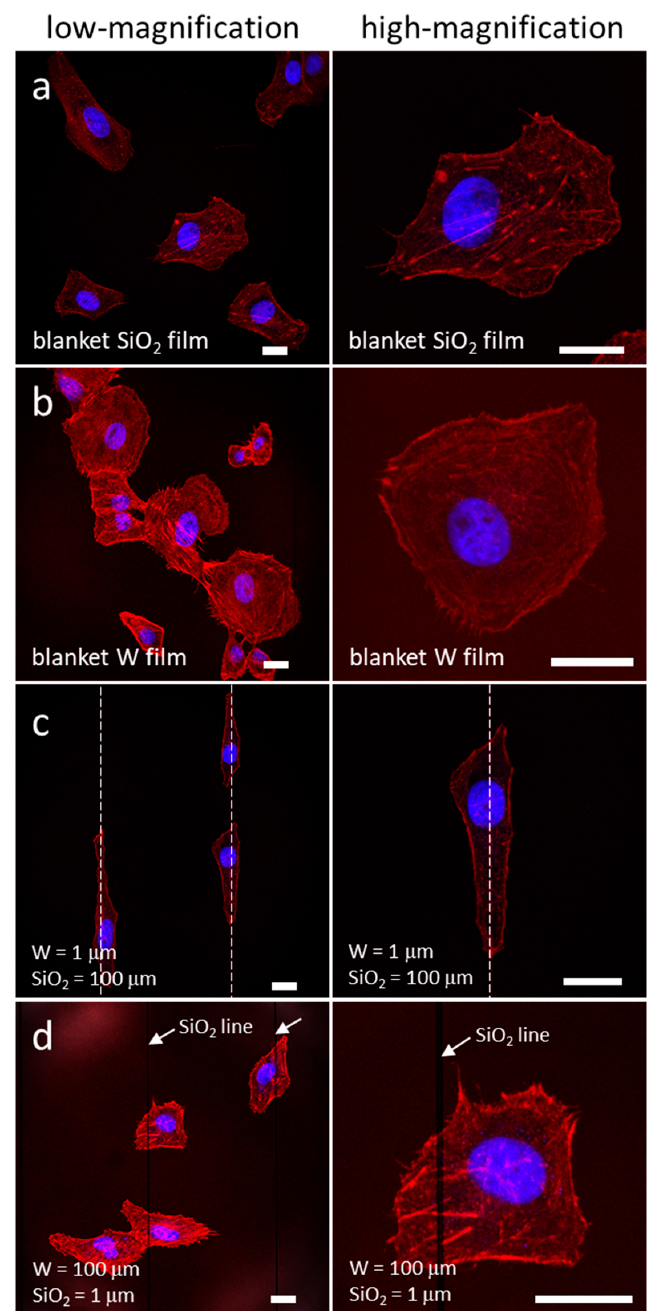
Figure 1. Low and high magnification fluorescence confocal micrographs of adherent cells on blanket ( a ) SiO 2 and ( b ) W films. Aligned cells on the comb structures with a W line width of 1 µm and SiO 2 of 100 µm are shown in ( c ). ( d ) shows irregularly shaped cells on the comb structure with 1 µm wide SiO 2 lines separated with 100 µm of W. Cell concentration is ~1 × 10 5 cells/mL incubated for 24 h. Scale bars represent 20 µm.